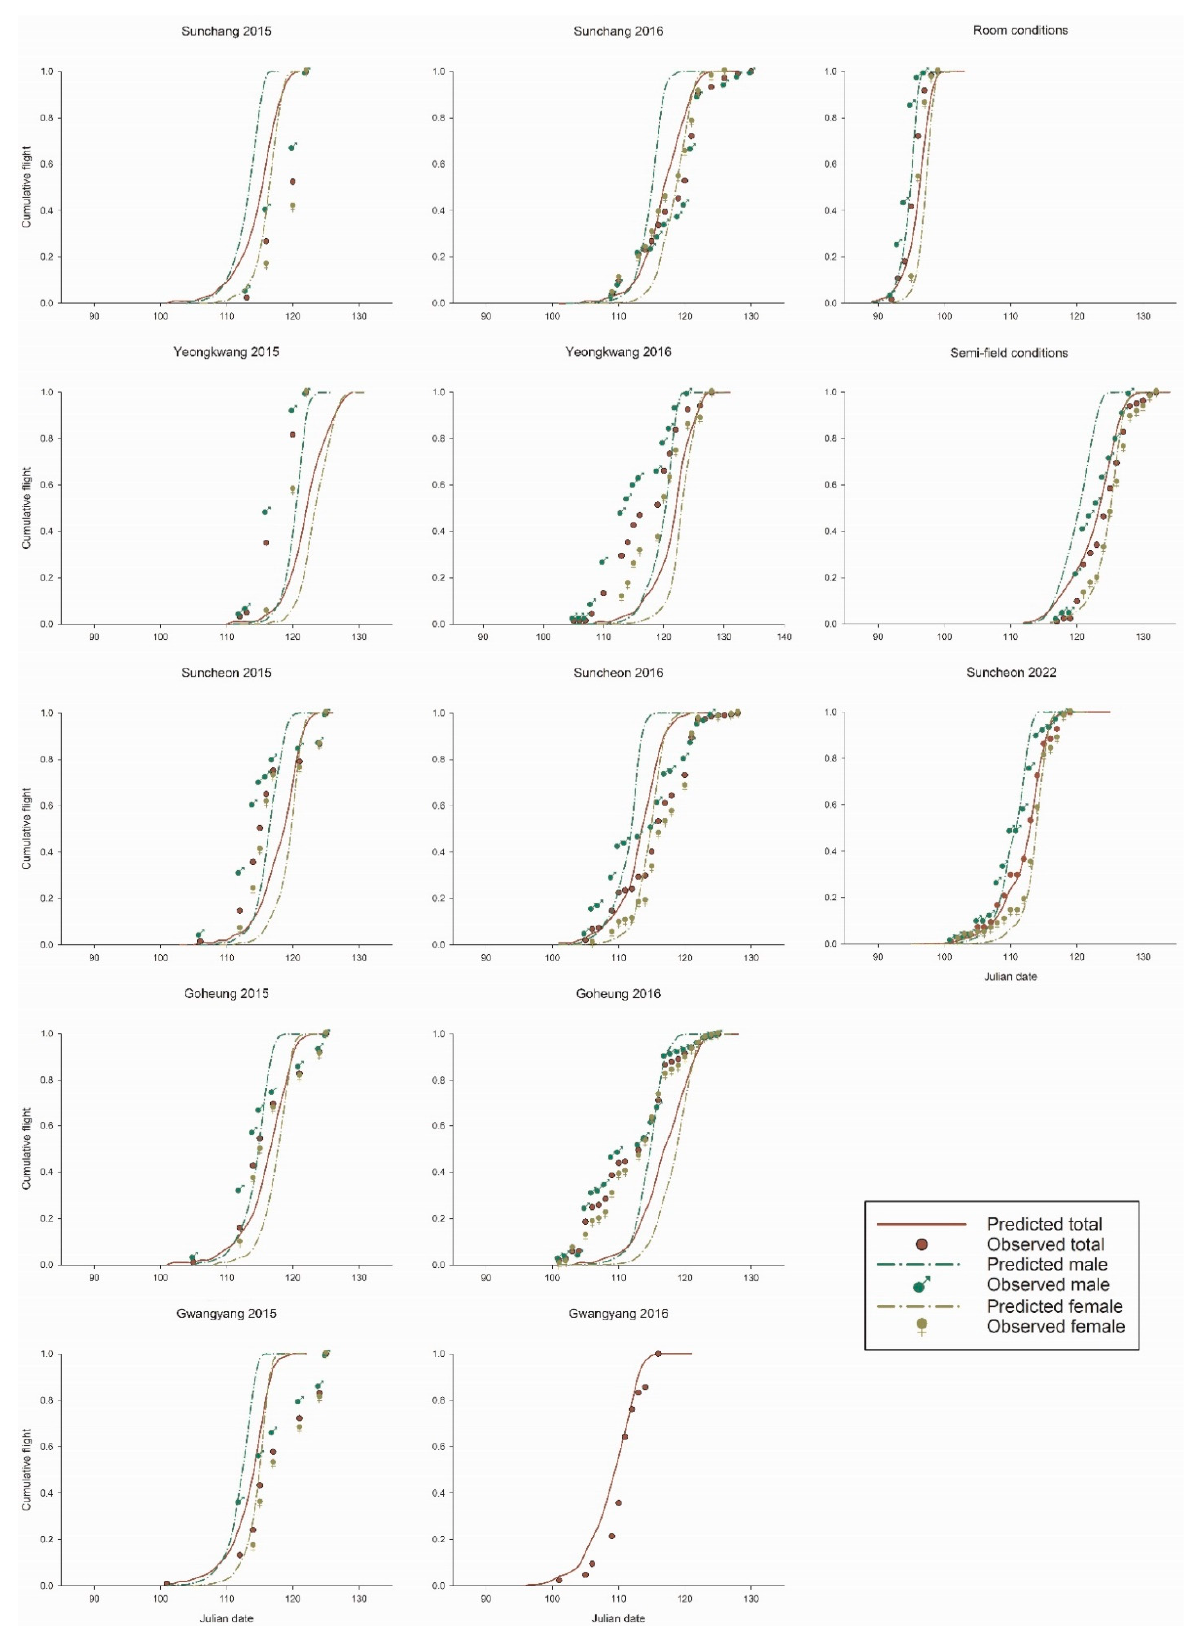
Figure A1. Observed and predicted cumulative flight of Eurytoma maslovskii at different locations and conditions in 2015–2016 and 2022.